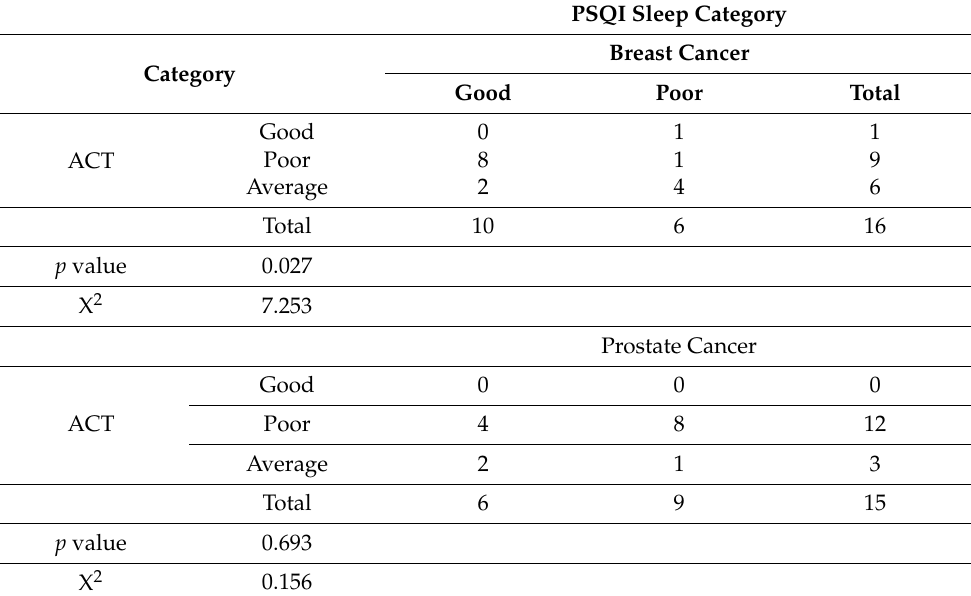
Table 4. Cross Tabulation of ACT-sleep quality vs. PSQI-sleep quality in breast and prostate cancer